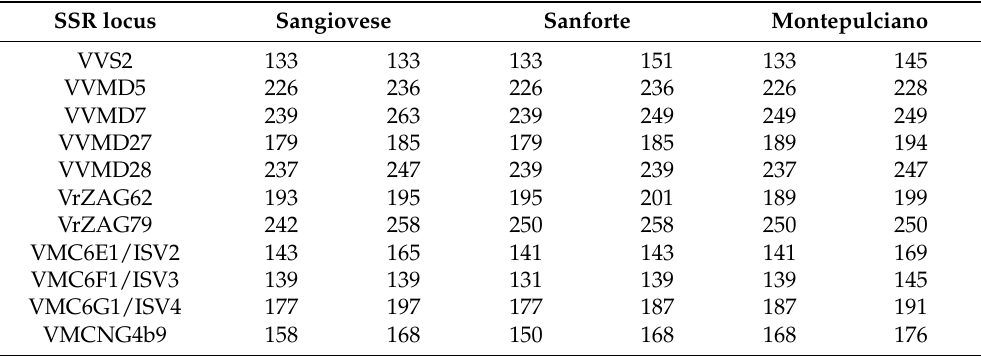
Figure 2. Standard bunch at maturity and standard adult leaf of the three grapevine cultivars revealed by SSR analysis (Sangiovese: ( A , D ); Sanforte: ( B , E ); Montepulciano: ( C , F )). The photographs are from the grapevine germplasm vineyard collection of CREA—Research Center for Viticulture and Enology in Arezzo (43 ◦ 47 (cid:48) 53 (cid:48)(cid:48) N, 11 ◦ 82 (cid:48) 43 (cid:48)(cid:48) E, Italy). Table 2. Allele sizes at 11 SSR loci of Sangiovese, Sanforte, and Montepulciano (lengths are expressed in base pairs). The varietal identification was carried out according to [41,55,56]. SSR locus Sangiovese Sanforte